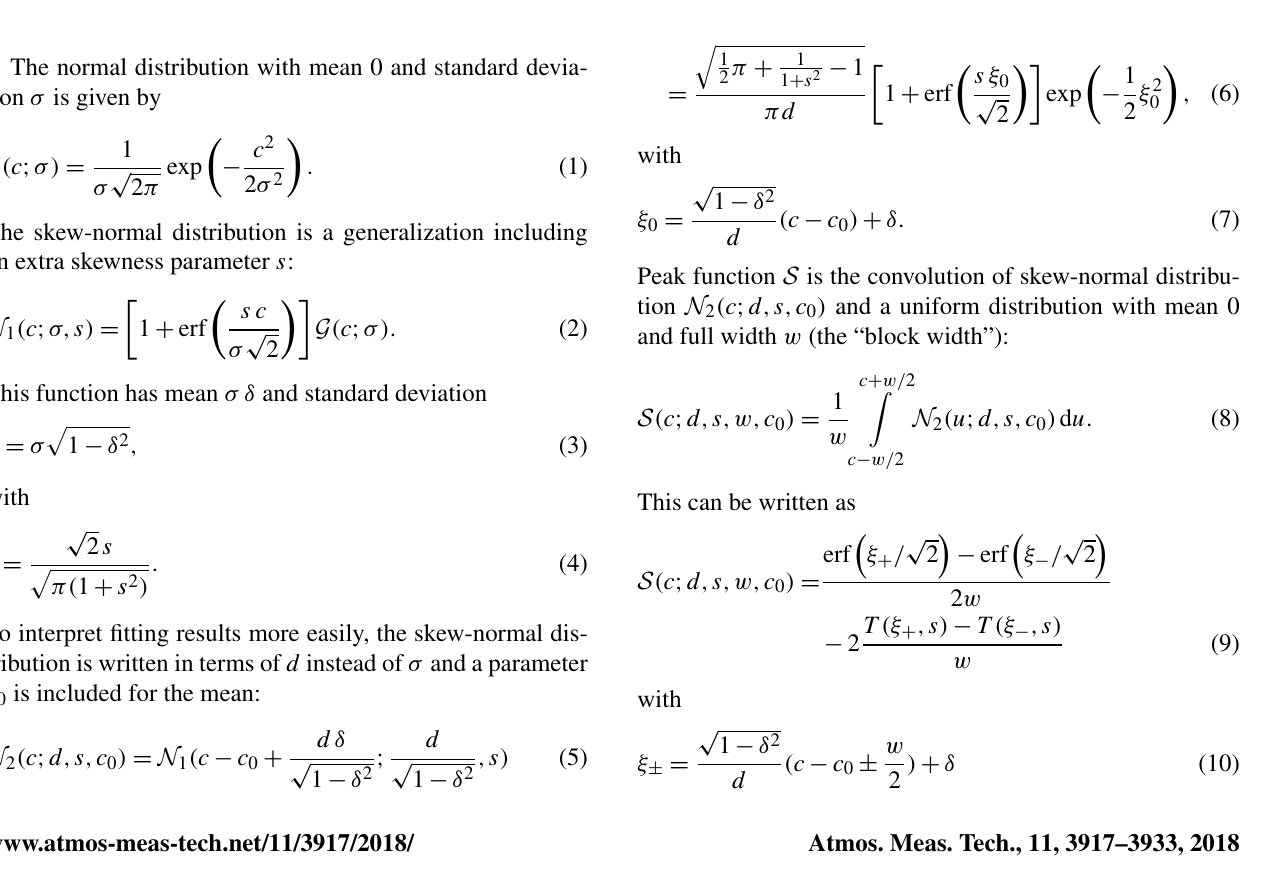
Figure 5. SWIR ISRF determined from on-ground measurements with the five on-board diode lasers. The upper panels (a) show the shapes of the ISRF at location: columns 154, 341, 471, 659 and 813 and rows 24, 76, 118, 155 and 191. The middle panels (b) show the same data on a logarithmic scale. The lower panels (c) show the difference between the ISRF data points and the ISRF fit (end of stage 4).